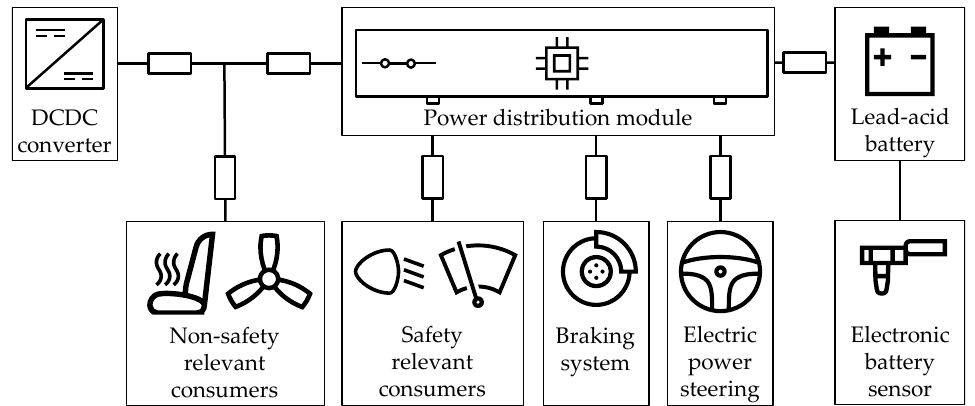
Figure 2. Powernet topology design to potentially ensure safe supply for safety-relevant consumers